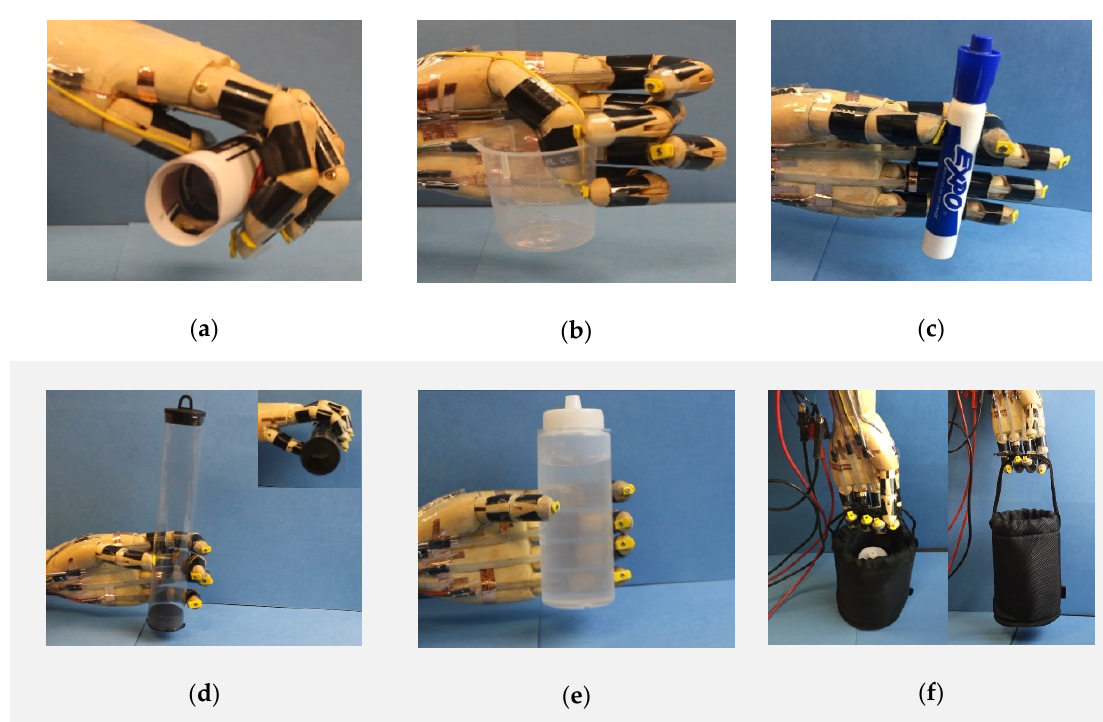
Figure 6. The biomimetic prosthetic hand can hold objects of different sizes and shapes and can carry different weights. ( a ) Holding a paper tube with a diameter of 30 mm. ( b ) Grabbing a plastic beaker. ( c ) Picking up a marker pen with a diameter of 20 mm. ( d ) Carrying a plastic tube with a weight of 2.12 g. ( e ) Holding a bottle of water with a weight of 200 g. ( f ) Lifting a basket with a weight of 252 g.